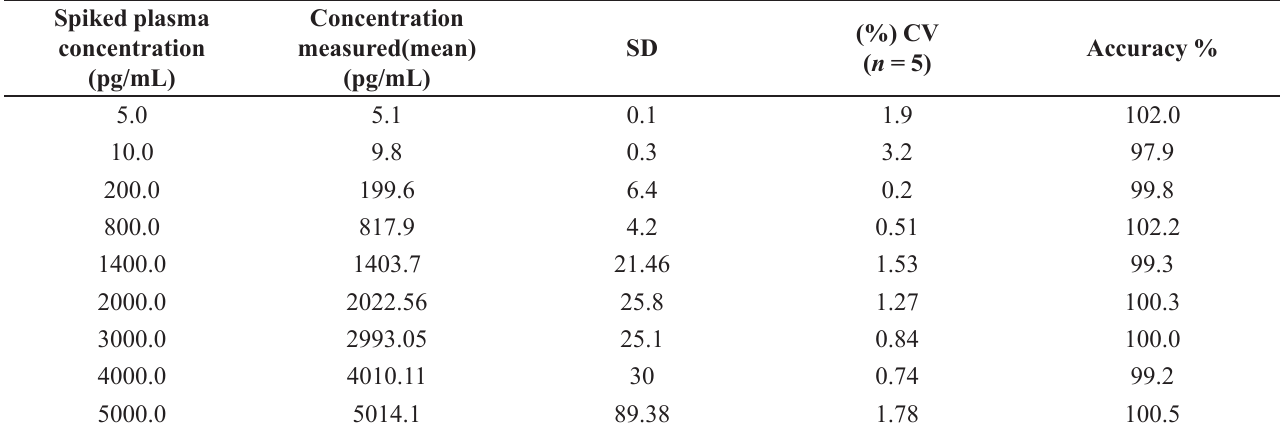
TABLE I - Calibration curve details from one batch of the validation section Spiked plasma